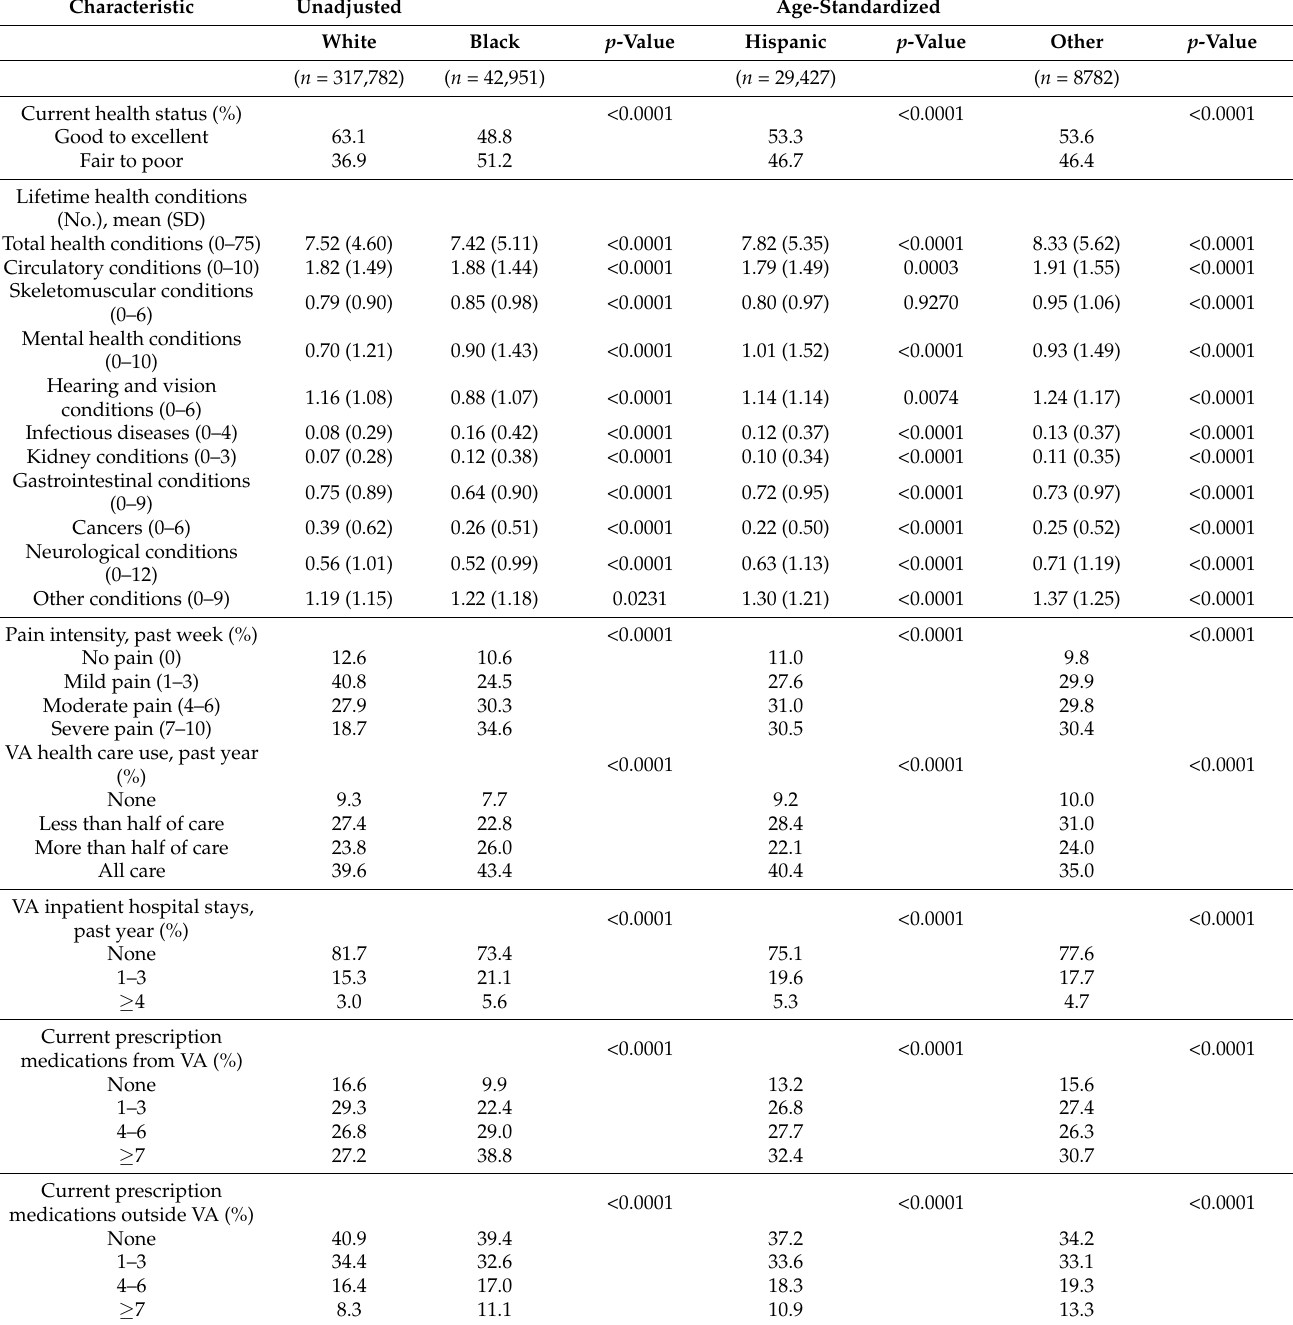
Table 3. Health-related Characteristics of Men from the Million Veteran Program by Race and